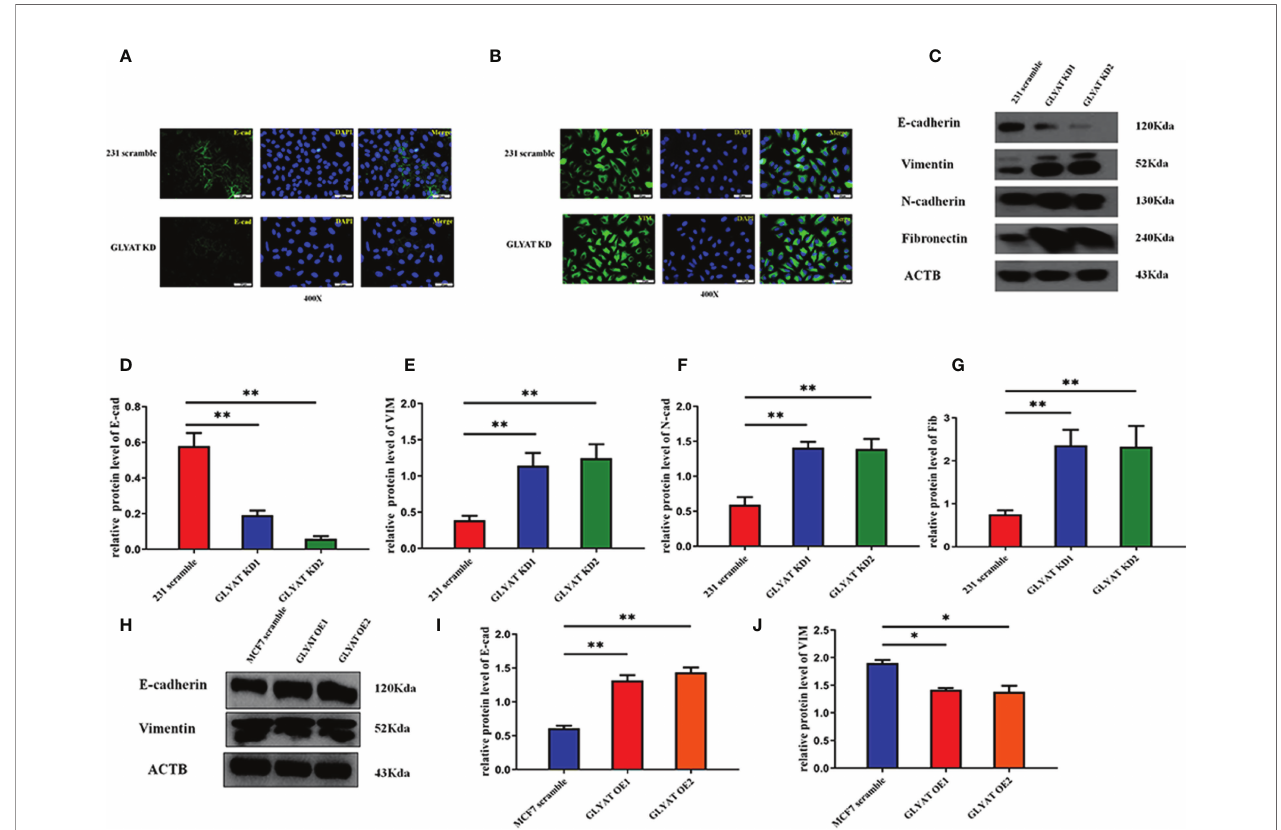
FIGURE 3 | GLYAT suppresses EMT phenotype in BC cells. (A, B) The immuno fl uorescence assay showed that E-cadherin expression was decreased and vimentin expression was increased after the treatment of GLYAT KD. (C – G) Protein levels of E-cadherin was reduced, whereas the levels of vimentin, N-cadherin, and fi bronectin were increased in MDA-MB-231 cells following GLYAT inhibition. (H – J) Protein levels of E-cadherin were increased whereas the expression of vimentin was reduced in GLYAT OE MCF-7 cells. *p < 0.05, **p < 0.01. Scale bars are 25 m